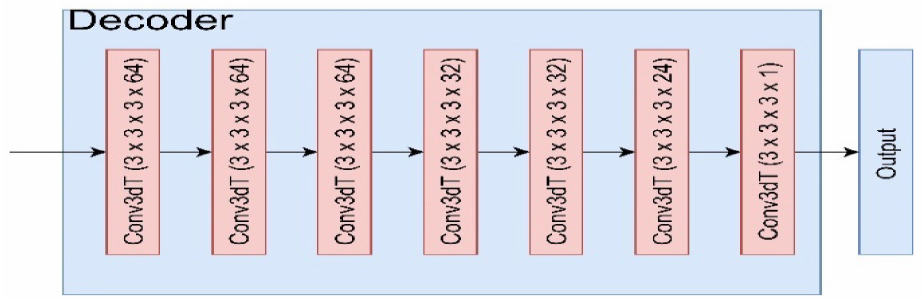
Figure 5. Structure of deconvolution decoder.